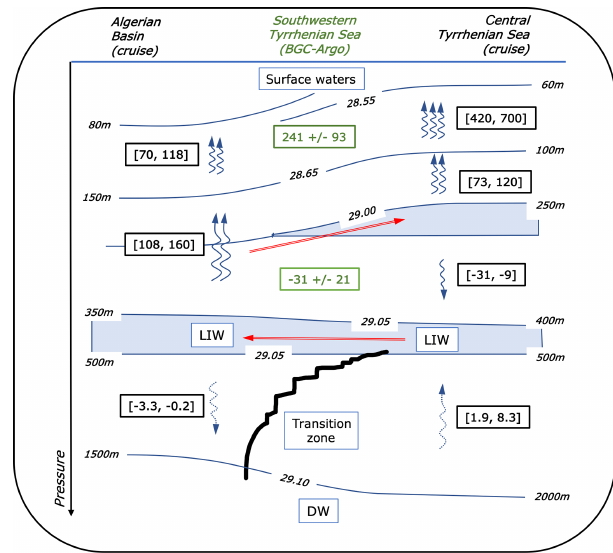
Figure 15. Vertical fluxes of nitrate F NO (µmolm − 2 d − 1 ) in the 3 presence of thermohaline staircases. Range of estimations reported from Table 6 for the stations collected during the PEACETIME cruise (in black) or computed from float 6901769 (in green), with positive diffusive flux oriented upward. Proposed isopycnal advec- tion is indicated by the red